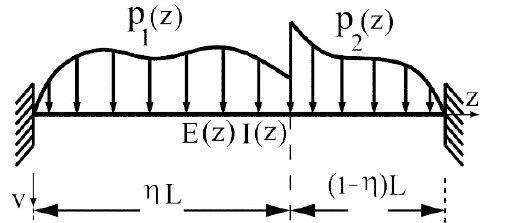
The end moments are found using Equation (8) as below.